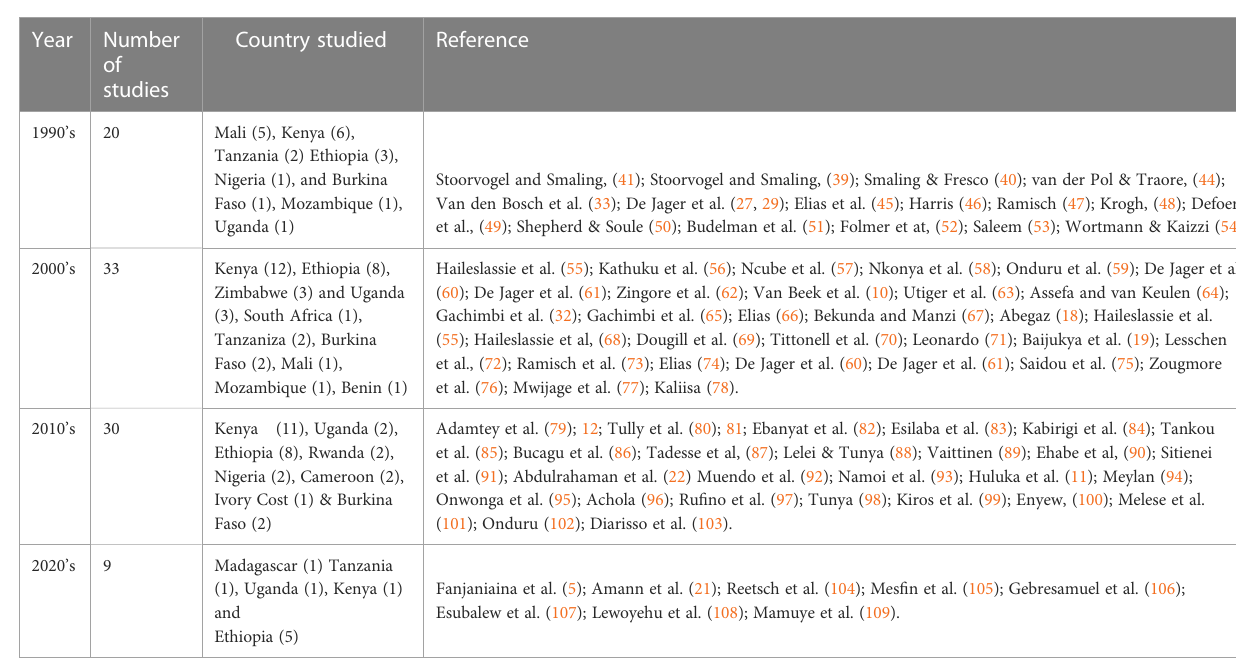
TABLE 1 Chronological trend of nutrient fl ow and budgets studies in SSA farming systems.